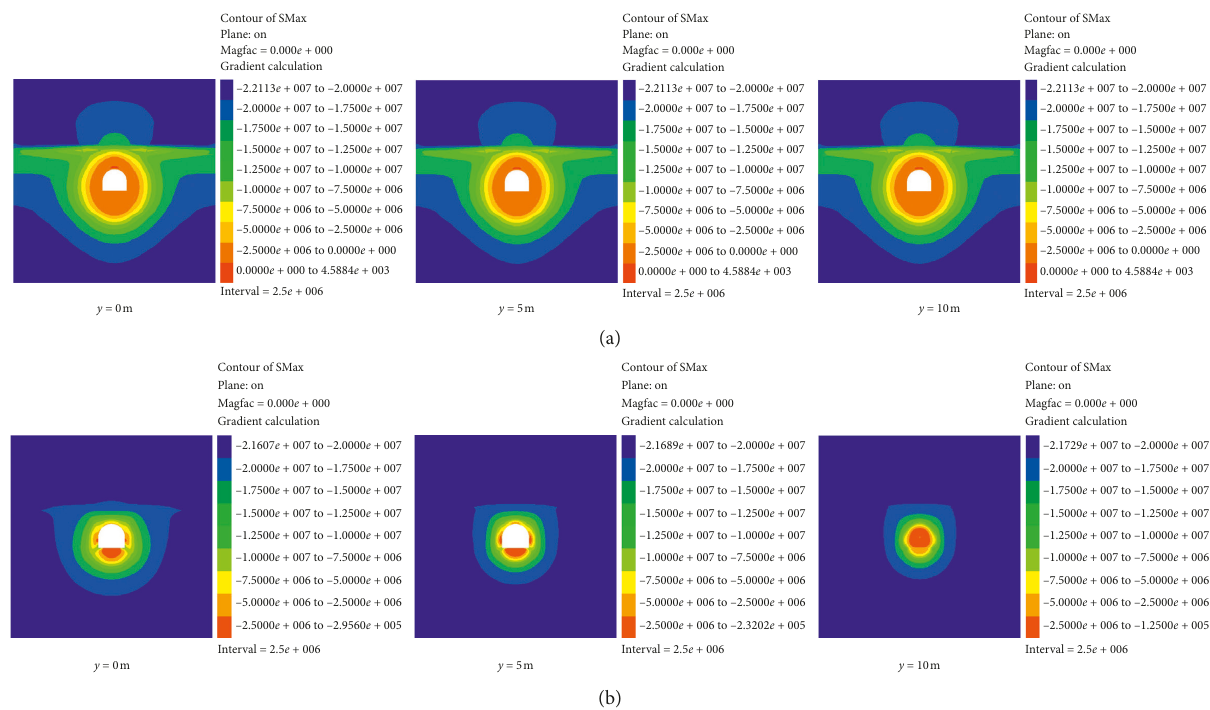
Figure 7: Maximum principal stress distribution of the tunnel floor after excavation: (a) plan A; (b) plan B.